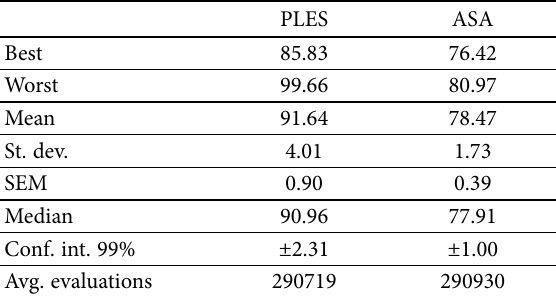
Table 7. Performance of the PLES and the ASA for group transportation in Task 2